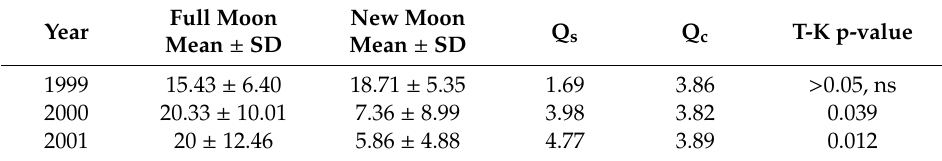
Figure 6. Box-plot with error bars of the analysis of variance (one-way ANOVA) results comparing the average number of nests oviposited per day for the four phases of the lunar cycle (full moon—FM, last quarter—LQ, new moon—NM, first quarter—FQ) over the three reproductive seasons: ( a ) 1999, ( b ) 2000, and ( c ) 2001. Numbers below or above the error bars represent the average and standard deviation (average ± SD). Table 3. Results from the Tukey–Kramer test (T-K) between full moon and new moon phases, using a Qcritical (Qc) of k = 4 and alfa = 0.05. Variables were Log n -transformed.